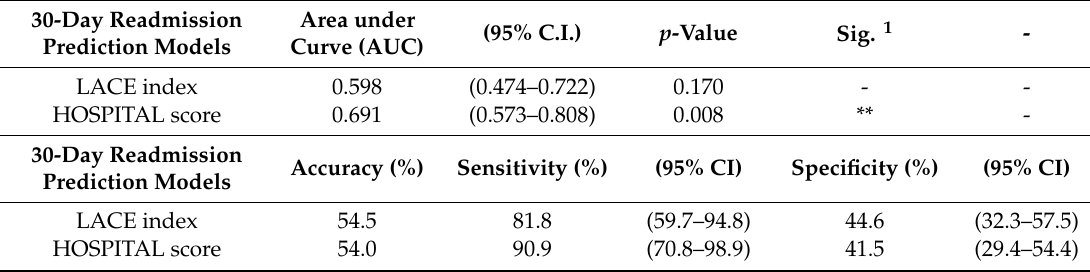
Figure 3. Receiver operating characteristic (ROC) curves of the LACE index and HOSPITAL score prediction models for 30-day readmission after acute hospitalization of a home care patient cohort of a medical center a ffi liated home care unit in Taiwan, 2017 ( n = 87). Table 2. Area under curve (AUC), sensitivity, and specificity of the LACE index and HOSPITAL score prediction models for 30-day readmission after acute hospitalizations of a home care patient cohort of a medical center a ffi liated home care unit in Taiwan, 2017 ( n =